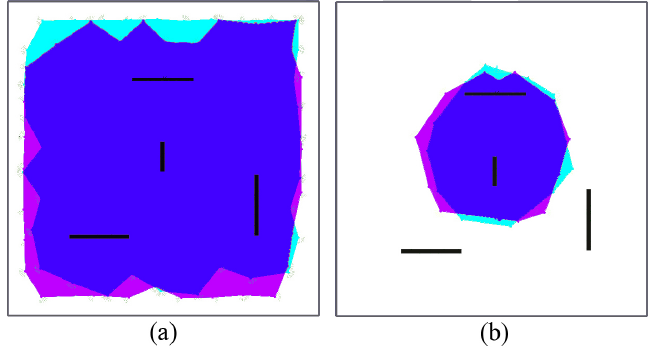
Figure 9. Deployment with geographic routing: area difference with and without obstacles: ( a ) initial; ( b )